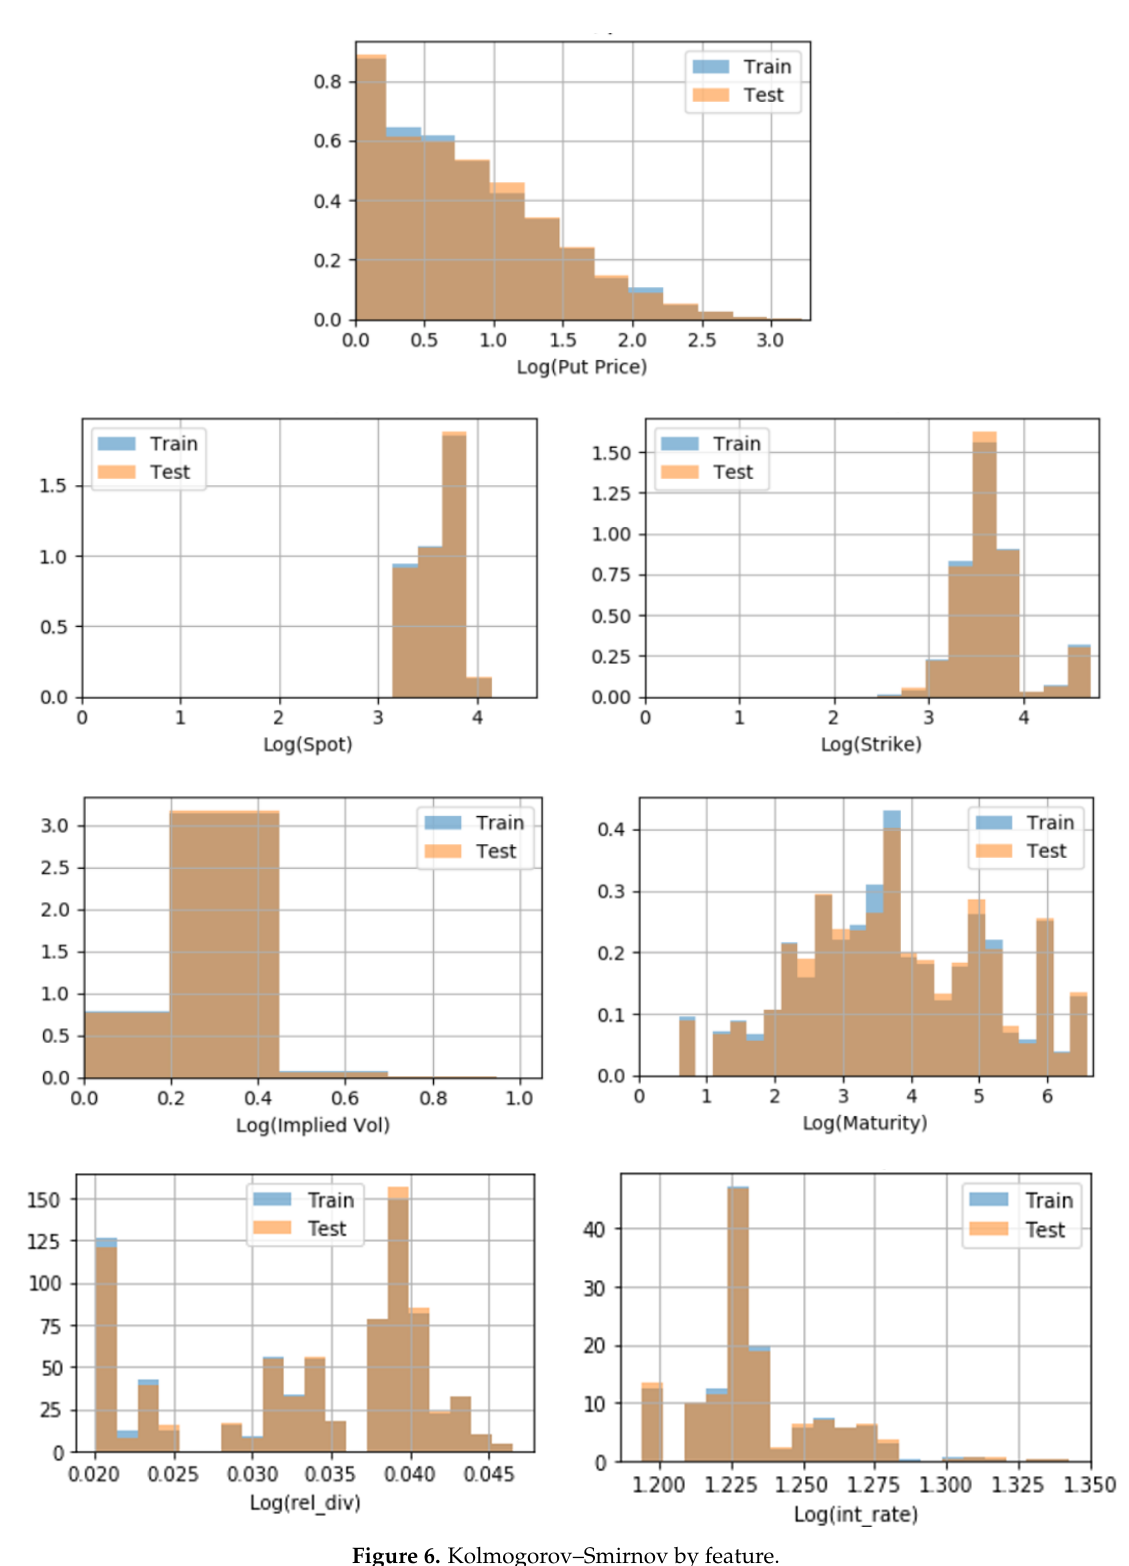
Figure 6. Kolmogorov–Smirnov by